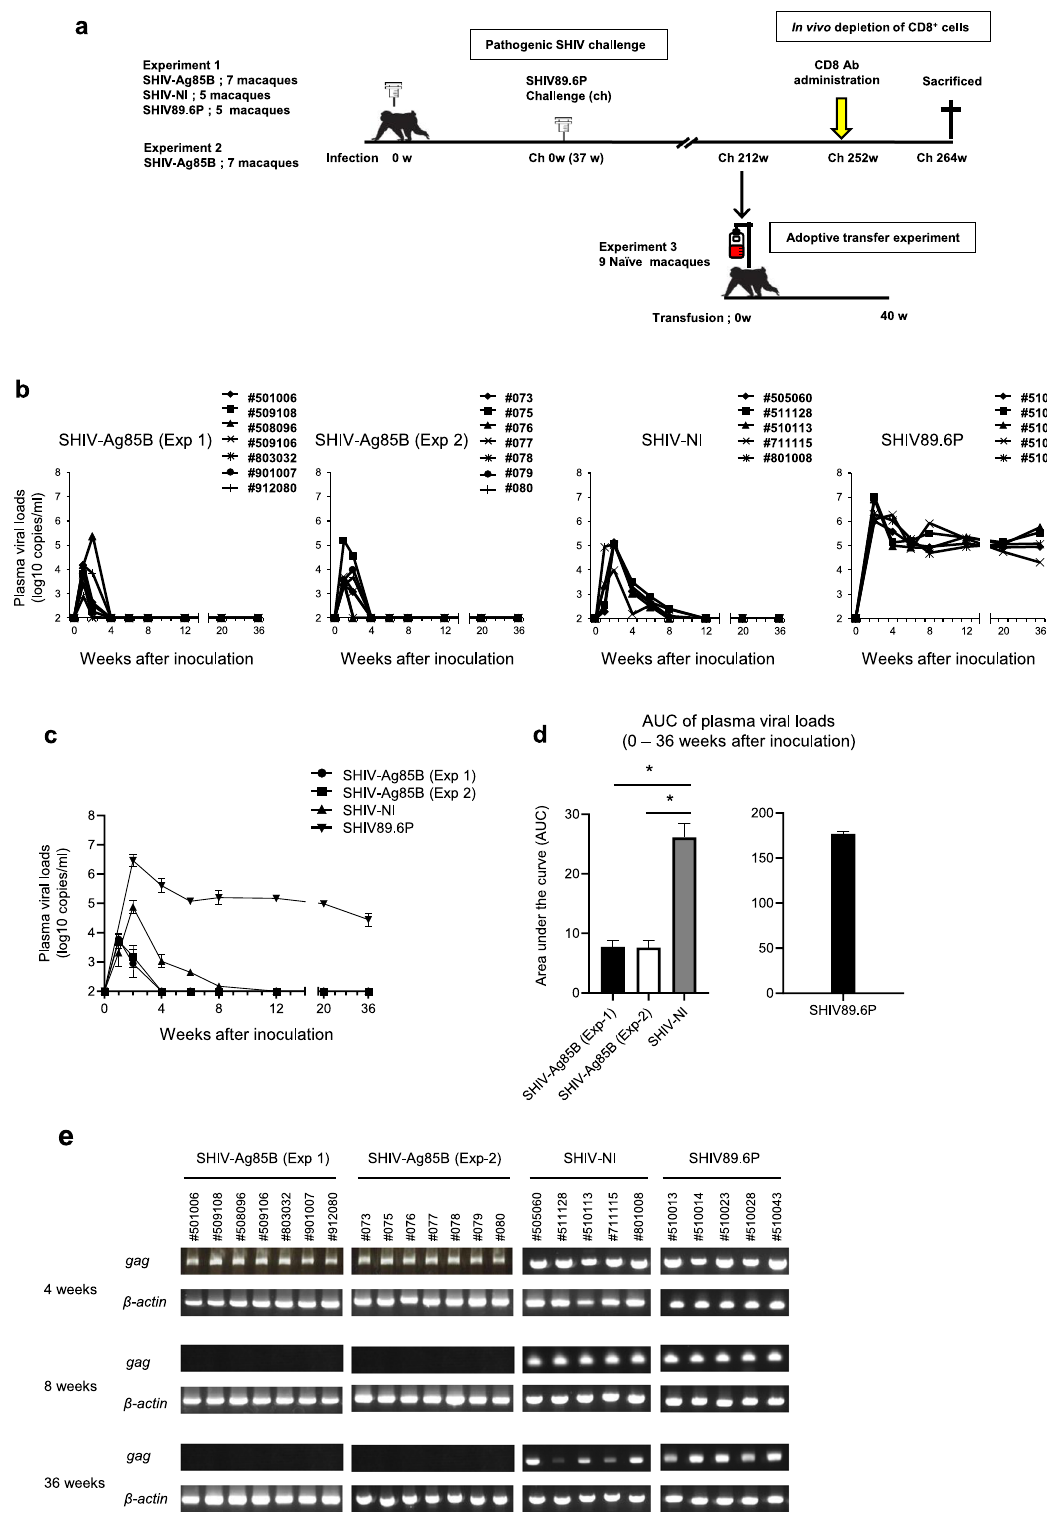
Fig. 2 Kinetics of viral loads and detection of gag DNA in macaques inoculated with SHIVs. a Experimental design, SHIV infection, adoptive transfer experiment, CD8 + cell-depletion study, and necropsy time points. b Plasma viral loads in macaques inoculated with SHIV-Ag85B (Exp 1), SHIV-Ag85B (Exp 2), SHIV-NI, and SHIV89.6P. Plasma viral loads were measured by quantitative RT-PCR. The detection limit of plasma viral load was 100 copies/ml. c Mean plasma viral loads in inoculated macaques. The lines indicate each group means and error bars represent means ± SEM. d Area under curve (AUC) of plasma viral loads in inoculated macaques between 0 and 36 weeks post inoculation. Error bars represent means ± SEM. Statistical analysis was performed using Kruskal – Wallis test. * P < 0.05. e Gag DNA in PBMCs of the macaques after SHIV-Ag85B (Exp 1), SHIV-Ag85B (Exp 2), SHIV-NI, and SHIV89.6P inoculation were detected by nested PCR for the SIV gag -speci fi c region. β -Actin was used as a